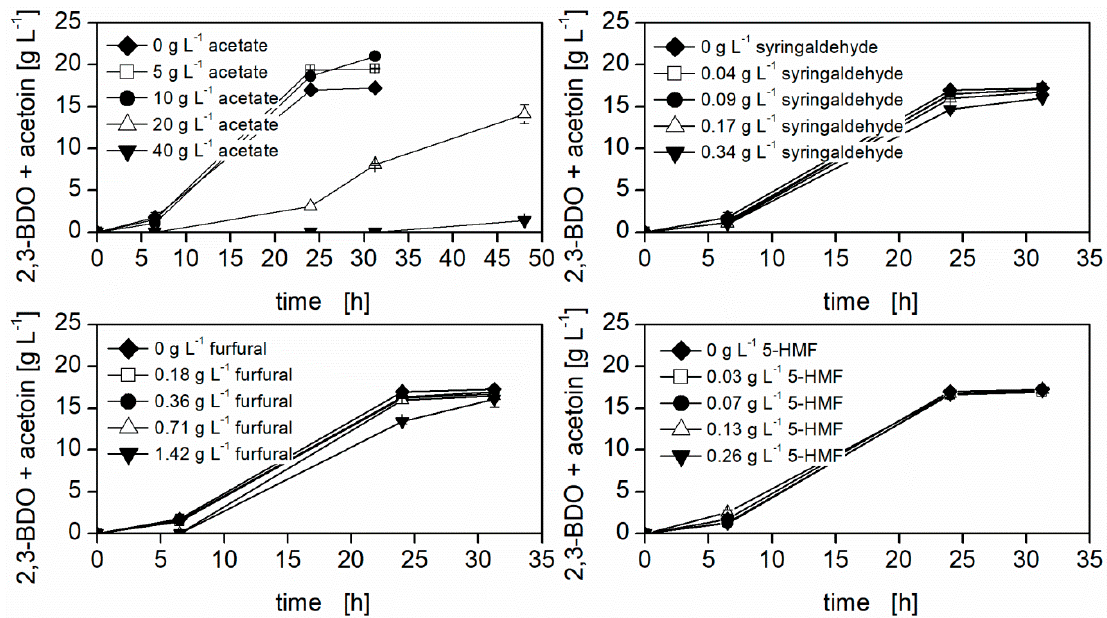
Figure 3. Production of 2,3-BDO and acetoin from 100 g L − 1 xylose in a modified basal media with different amounts of inhibiting compounds. Cultivations were performed with B. vallismortis B-14891 in 24 well microtiter plates at 37 °C and 320 rpm, buffered with 0.2 M MES at pH 6.7. The cultivations were carried out in duplicates.